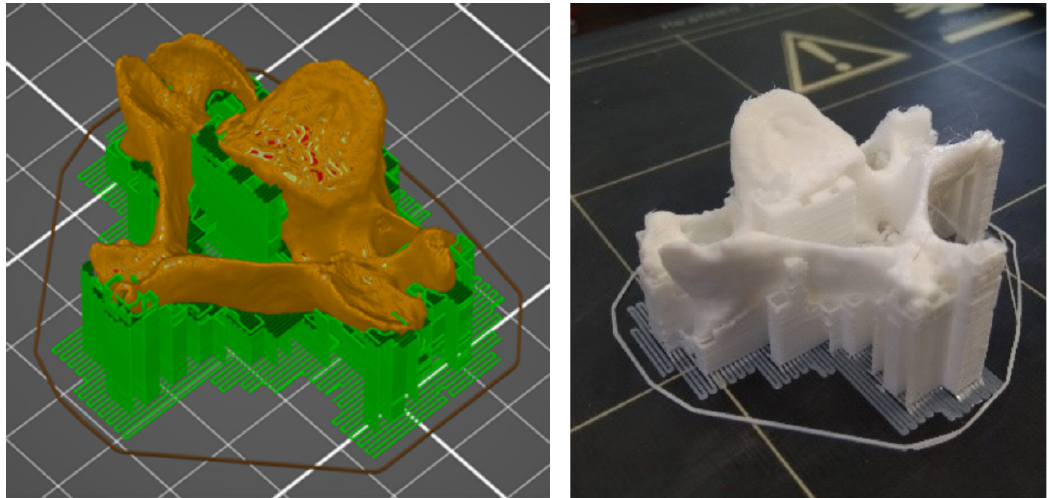
Figure 3 . Model generated in PrusaSlicer ( left ) and printed model of the vertebra ( right ).